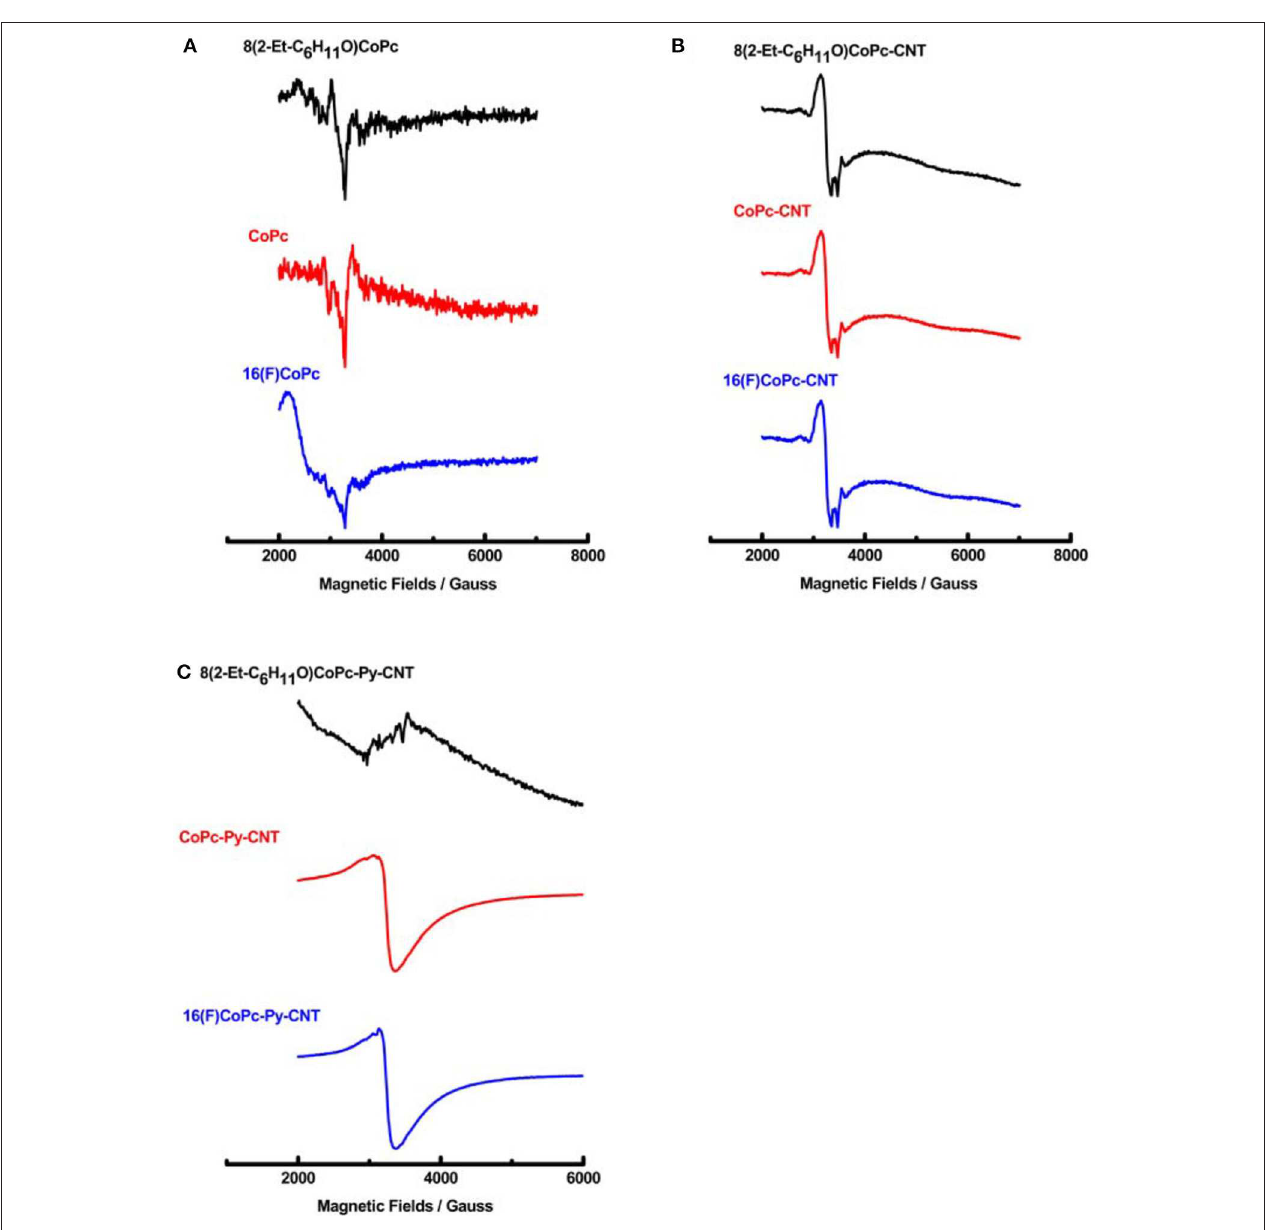
FIGURE 2 | (A) EPR spectra of 8(2-Et-C 6 H 11 O)CoPc, CoPc, and 16(F)CoPc. (B) EPR spectra of 8(2-Et-C 6 H 11 O)CoPc-CNT, CoPc-CNT, and 16(F)CoPc-Py-CNT. (C) EPR spectra of 8(2-Et-C 6 H 11 O)CoPc-Py-CNT, CoPc-Py-CNT, and 16(F)CoPc-Py-CNT.